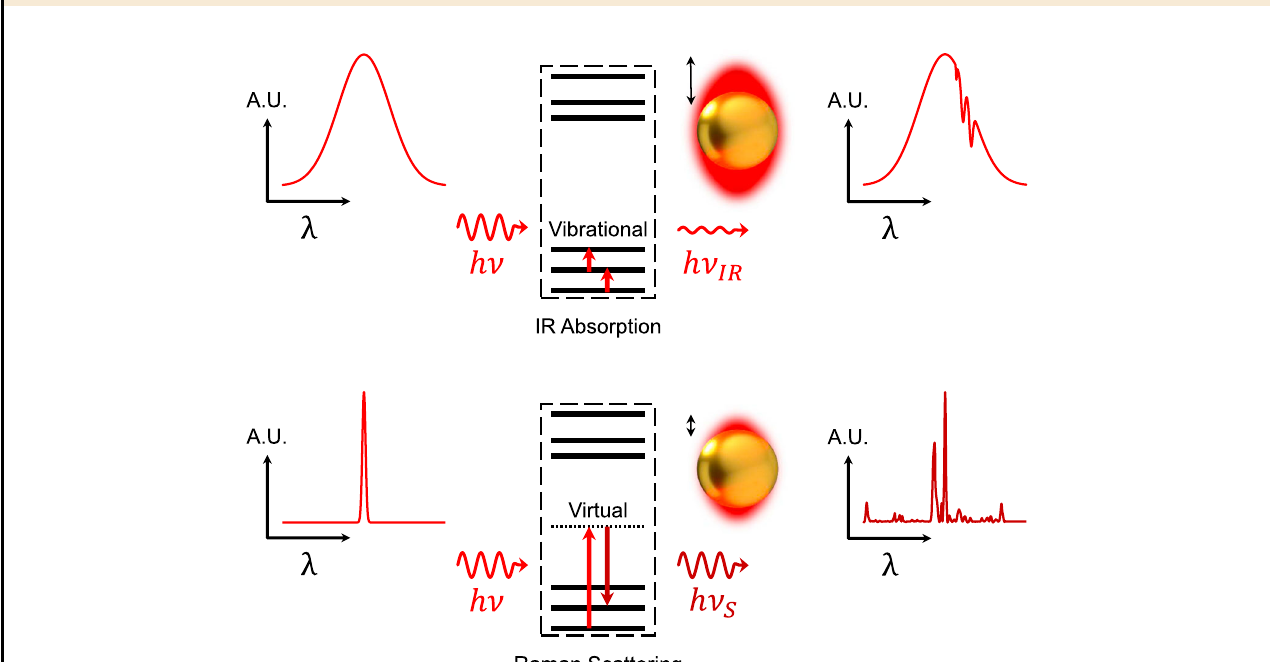
a protein analyte over a broad spectrum (Fig. 4a – e). The plas- monic resonance is electrostatically tuned to sweep continuously over the two protein vibrational bands, amide-I and amide-II. Based on this dynamic tunability, they combined both SEIRA and LSPR sensing in a single device and showed extraction of complex refractive indices of nanometer-thick samples on the